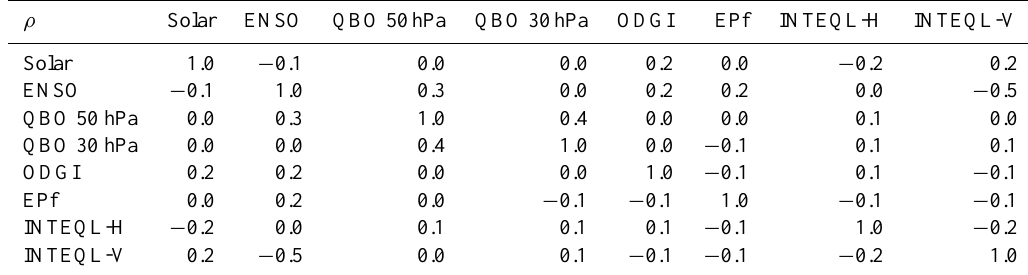
Table 1. Correlation coefficients at MLO between proxies with QBO @ 50hPa and 30hPa. ρ